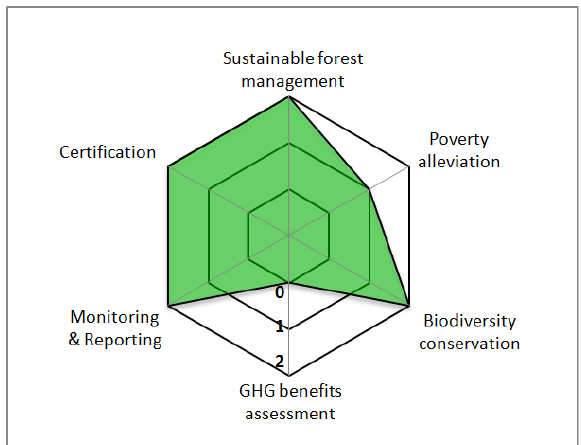
Figure 2. Summary of Forest Stewardship